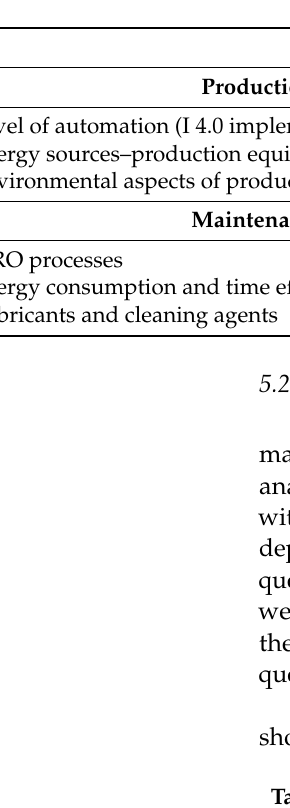
Table 3. Maturity model–environmental aspect indicators.